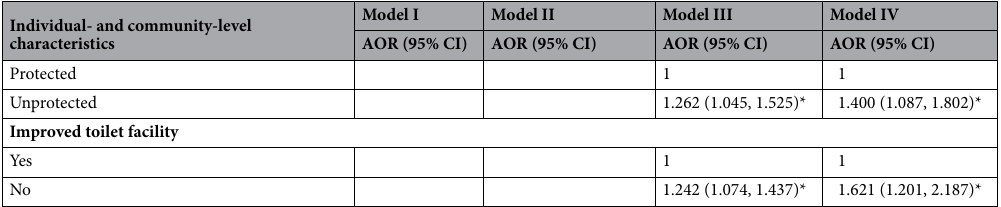
Table 3. multilevel logistic regression analysis for risk factors of infant mortality in rural Ethiopia, 2016. 1 reference category for categorical variable and *reference P -value < 0.0001. ANC Antenatal Care, AOR Adjusted